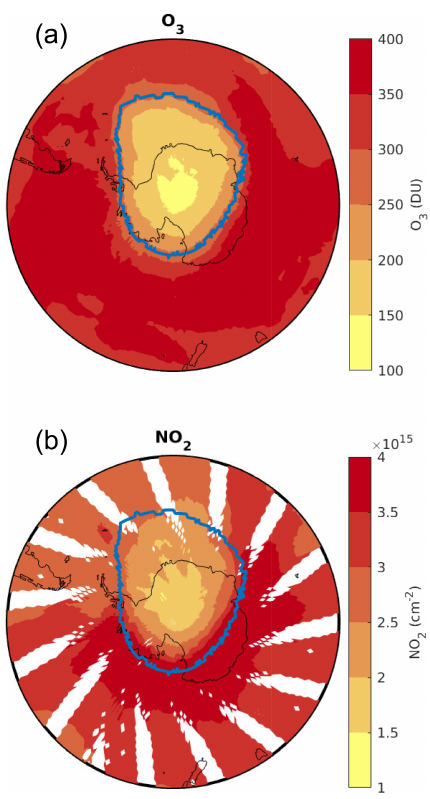
Figure 7. (a) ˆ A p vs. the average, cos ( latitude ) area-weighted NO 2 for the region from 60 to 90 ◦ S for observations inside the polar vor- tex (PV). Red triangles correspond to eQBO years, and blue circles correspond to wQBO years. The yellow line represents a linear fit to all data points, the red line represents a linear fit for eQBO years only, and the blue line represents a linear fit for wQBO years only. ρ values are displayed as in Fig. 4. Error bars indicate the 95% confidence interval for the mean. (b) Correlation of ˆ A p with the 5d running mean NO 2 column inside the polar vortex for eQBO years. Contour levels are shown for [ − 1, − 0 . 8, − 0 . 5, − 0 . 2, 0, 0.2, 0.5, 0.8, 1] with an additional black line for the zero contour. The stip- pling indicates that correlations are significant at the ≥ 95% level. Panel (c) is the same as panel (b) but for wQBO